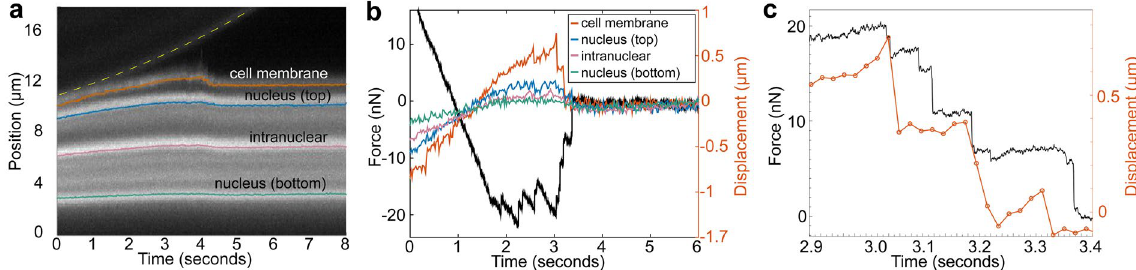
Figure 4. Simultaneous adhesion force and image data acquired for a fibronectin-coated AFM tip on a SKOV3 cell. ( a ) The kymograph shows motion of the AFM tip off the cell surface eventually leaving the FOV at ∼ 4 seconds (diagonal band at top highlighted with yellow dashed line), and several bright fluorescent regions of the cell - cell membrane (red), top of nucleus (green), punctate region within nucleus (cyan), and bottom of nucleus (magenta). ( b) Time synchronized AFM force data (black - left axis) and displacements (red, green, cyan, magenta - right axis) measured from images are displayed on the same plot. ( c ) Zoom in of ( b ) with only force data (sign of force inverted for clarity) and cell membrane displacement data displayed. Some force drops are associated with membrane displacements while others are